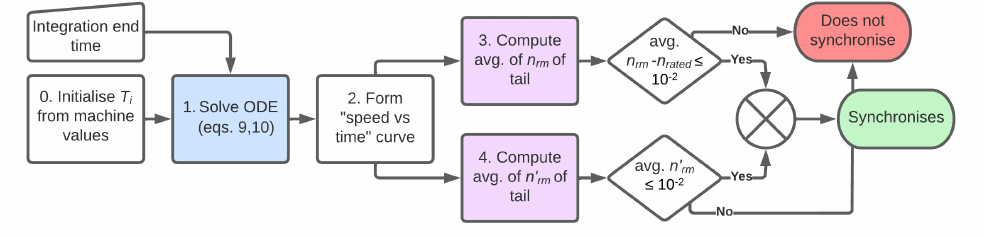
Figure 18. Flowchartimplementing the time-domain method (Chama et